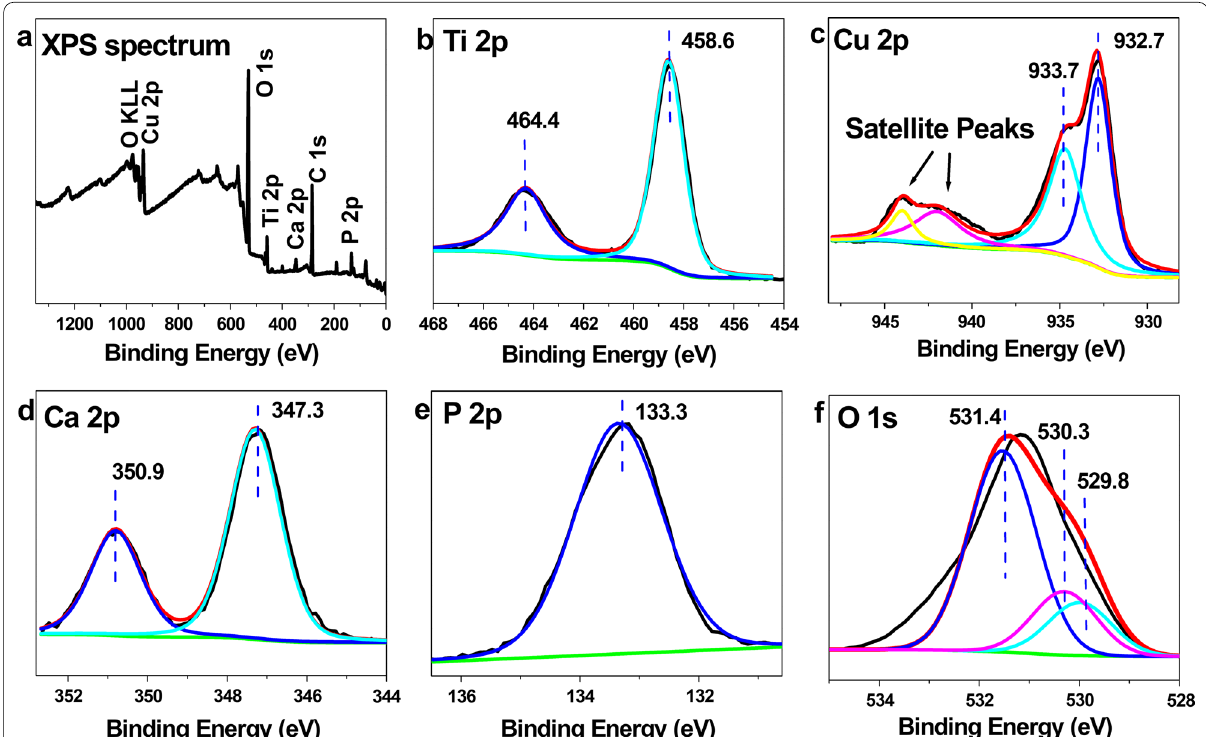
Fig. 4 XPS image of the microporous Cu‑TiO 2 coating. a XPS spectrum, b Ti2 p , c Cu2 p , d Ca2 p , e P2 p and f O1 s